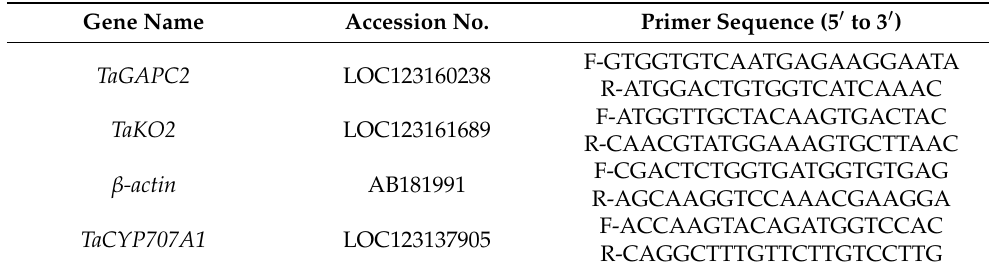
Table 2. Primers used to check the expression of different